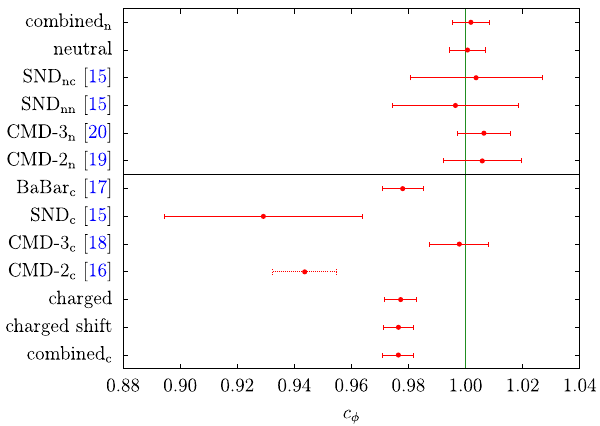
neutral and charged data are considered, respectively, and “charged shift” to the variant in which a shift in the BaBar c energy calibration is allowed, see main text for details. The inner errors for c ω refer to the fit uncertainties, the total ones are obtained by adding the systematic error from the variation of the UFD input in quadrature (a negligible effect for c φ , M φ , and Γ φ